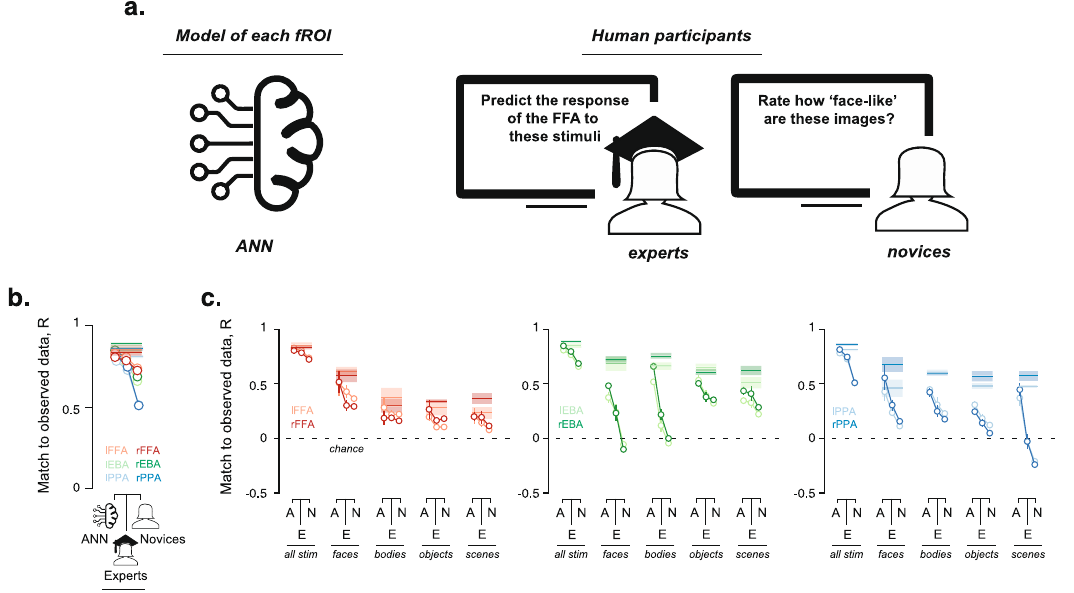
Fig. 3 Model-based predictions compared to novice participants and experts in the fi eld. a Schematic of the comparison between neural network models for each fROI (left) and human participants who were either Professors with several published papers on the human ventral visual cortex (experts) or participants from a crowd-sourced experimental platform (novices), and b Performance of the ANN-based encoding models (left column), experts (middle column), and novice participants (right column) at predicting the observed responses to stimuli. The connected lines indicate each fROI. For the behavioral data, each dot indicates the mean prediction and the errorbars indicate the s.e.m. across participants. Source data are provided as a Source Data fi le. c Comparison between ANN models (A), experts (E), and novice (N) participants at predicting the observed responses at the grain of individual stimuli within each of the four categories of stimuli used in the experiment for the FFA (left column), the EBA (middle column), and the PPA (right column). For the behavioral data, each dot indicates the mean and the errorbars indicate the s.e.m. across participants. The line and shaded regions indicate the ceiling for how good the models can be, based on the reliability of the data. Source data are provided as a Source Data fi